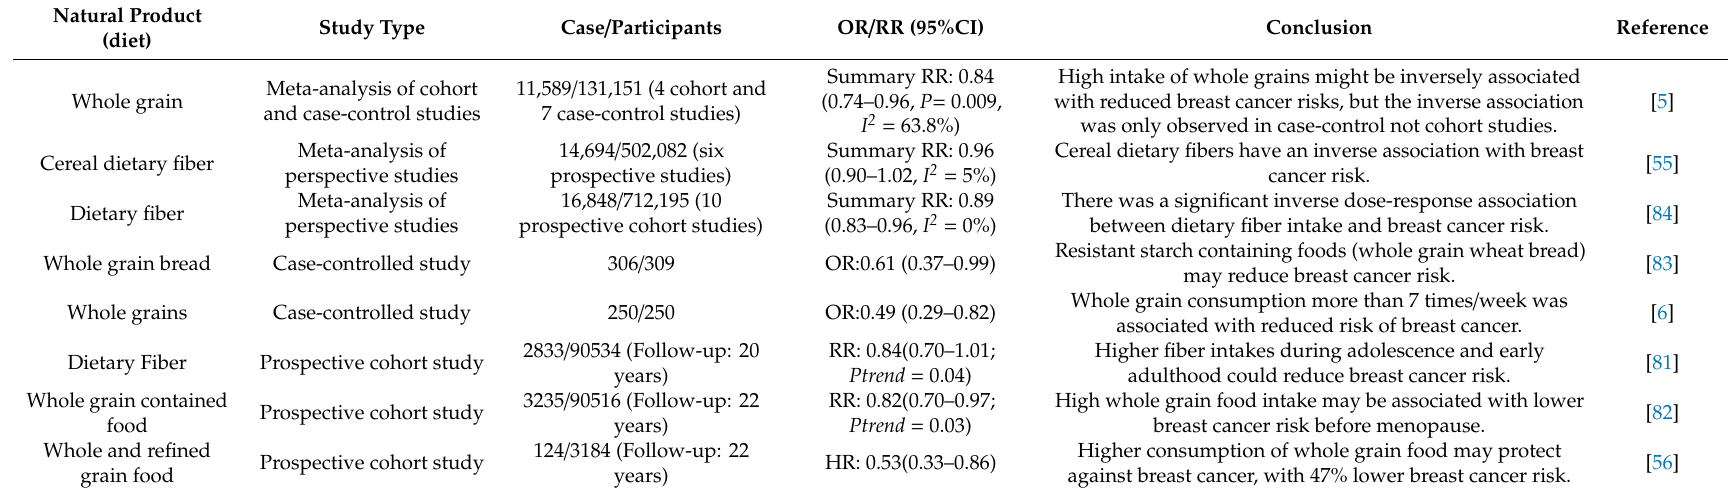
Table 3. Epidemiological and clinical evidences of breast cancer and whole grain